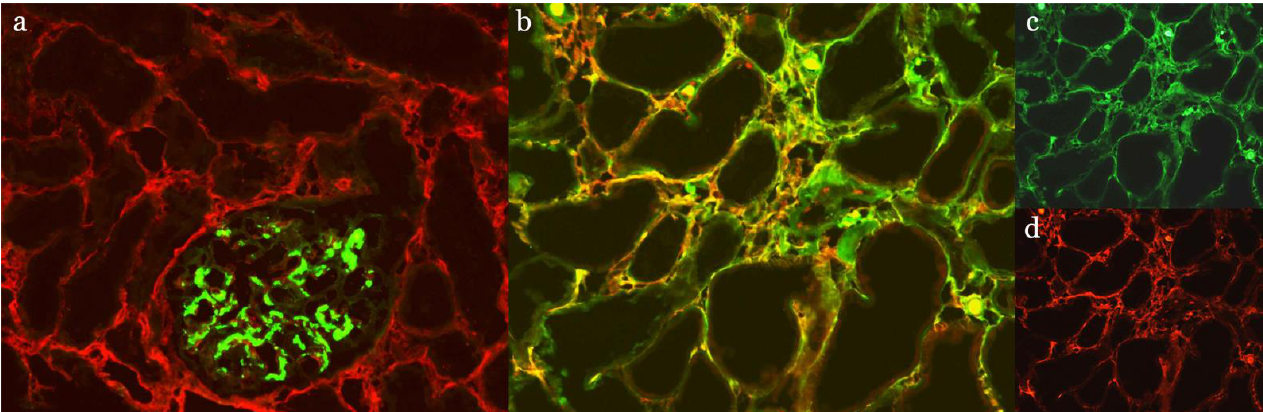
Figure 1. Immunofluorescent staining for immunoglobulin A (IgA) (green) and tissue transglutaminase (tTG) (red), and their colocalization (yellow) in the renal biopsies taken at the time of the IgA nephropathy (IgAN) diagnosis. ( a ) In a patient with IgAN without celiac disease, the IgA is only found in the glomerular mesangium. No colocalization of IgA and tTG is detected; ( b ) representative figure demonstrating colocalization of IgA and tTG (yellow) in the extracellular matrix around the renal tubuli in patients with both IgAN and celiac disease; ( c ) IgA; ( d ) tTG staining in the same specimen. Magnification 20x. Table 1. Background and follow-up data and biopsy findings among nine patients with IgA nephropathy (IgAN). At IgAN Diagnosis At CD